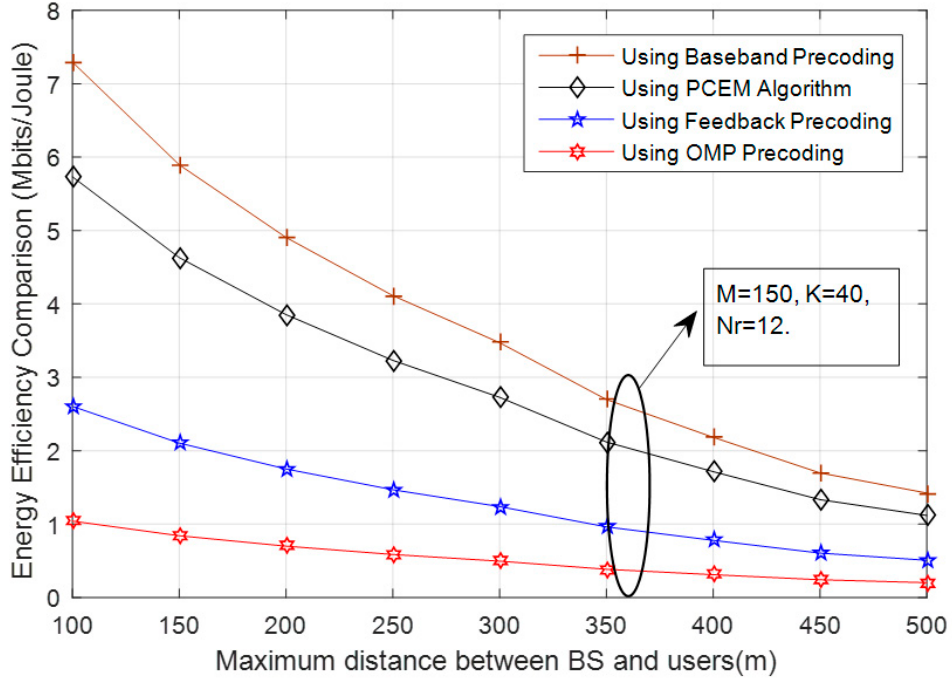
Figure 8. Comparison of the energy e ffi ciency of proposed and the reference